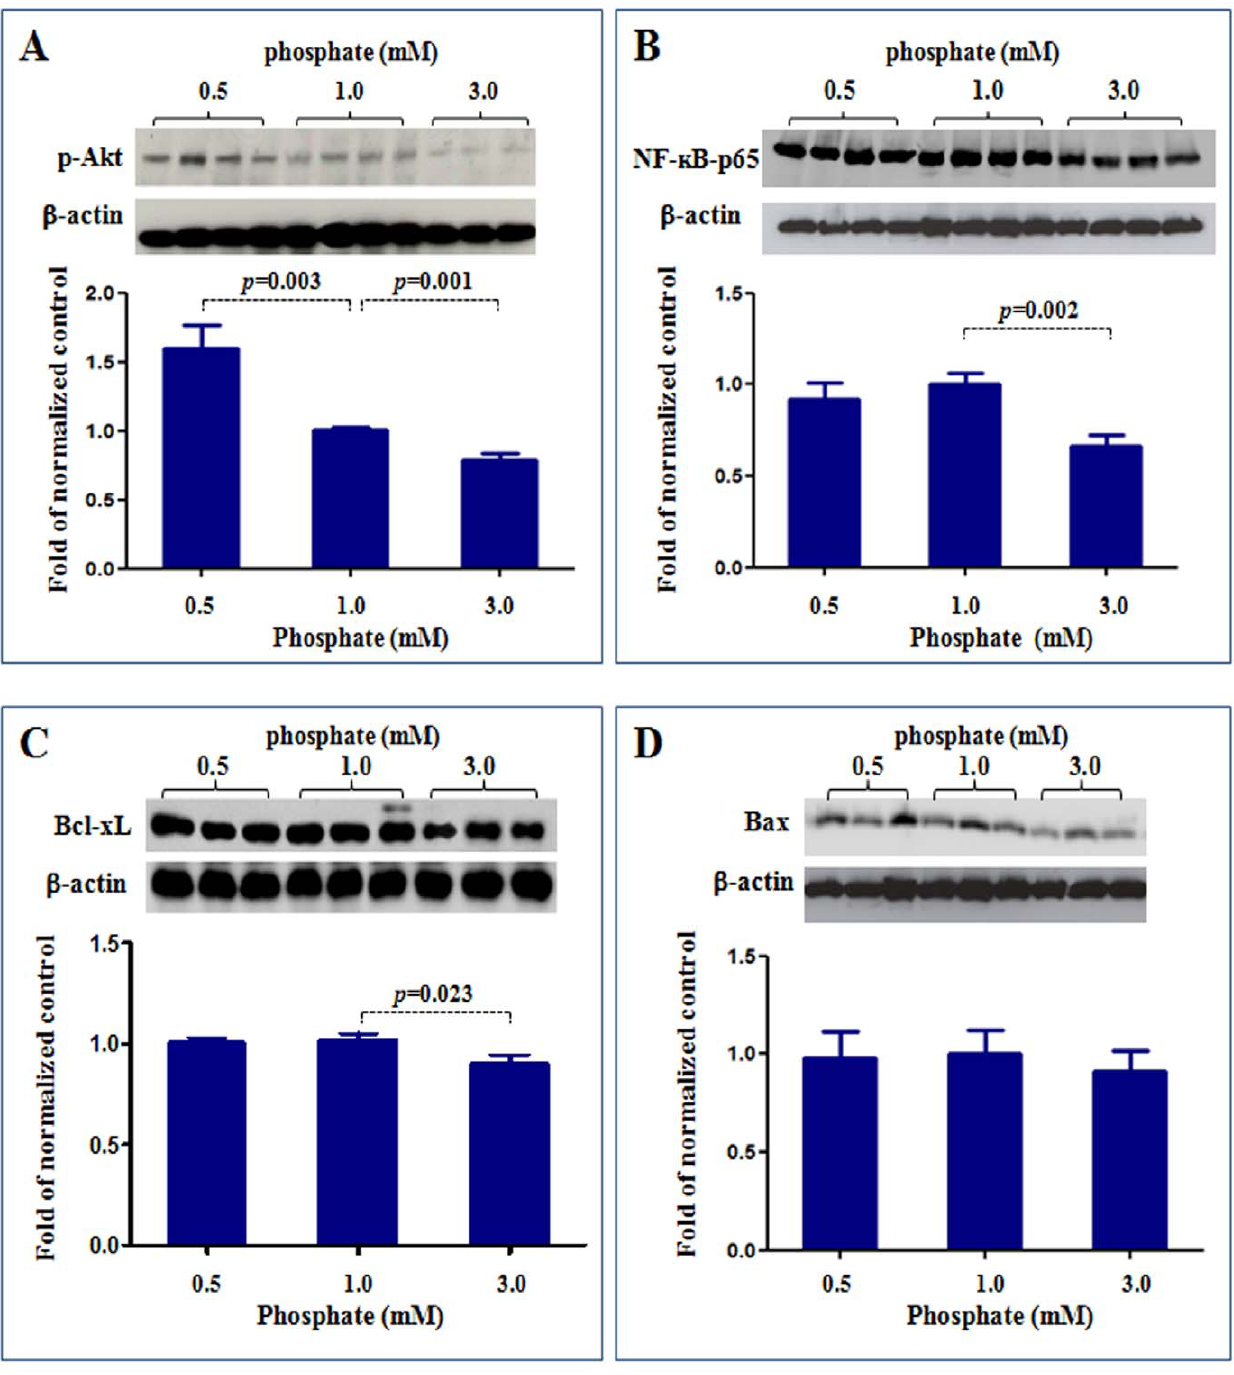
Figure 6. Western blot analysis of p-Akt, NFkB, Bcl-xL and Bax expressions. To validate the reverse-phase protein microarray data, we examined the protein expression for p-Akt, NF-kB-p65, Bcl-xL and Bax using western blot. Compared to the control cells exposed to physiologic phosphate level (1.0 mM), the cells exposed to simulated hypophospatemia (0.5 mM) showed significantly increased p-Akt (A), while the cells exposed to simulated hyperphospatemia (3 mM) showed significantly reduced p-Akt (A), NF-kB-p65 (B) and Bcl-xL (C). The levels of Bax were not significantly different between the three groups (D). P values vs control (1 mM phosphate). N=4 , 8. doi:10.1371/journal.pone.0023268.g006 abnormal phosphate levels affected the ability of acetylcholine (a physiological activator of eNOS) to stimulate NO production, a set of cells was incubated with 2 m M acetylcholine and the supernatant NO levels before (baseline) and 5 minute and 15 minute post acetylcholine stimulation was measured.